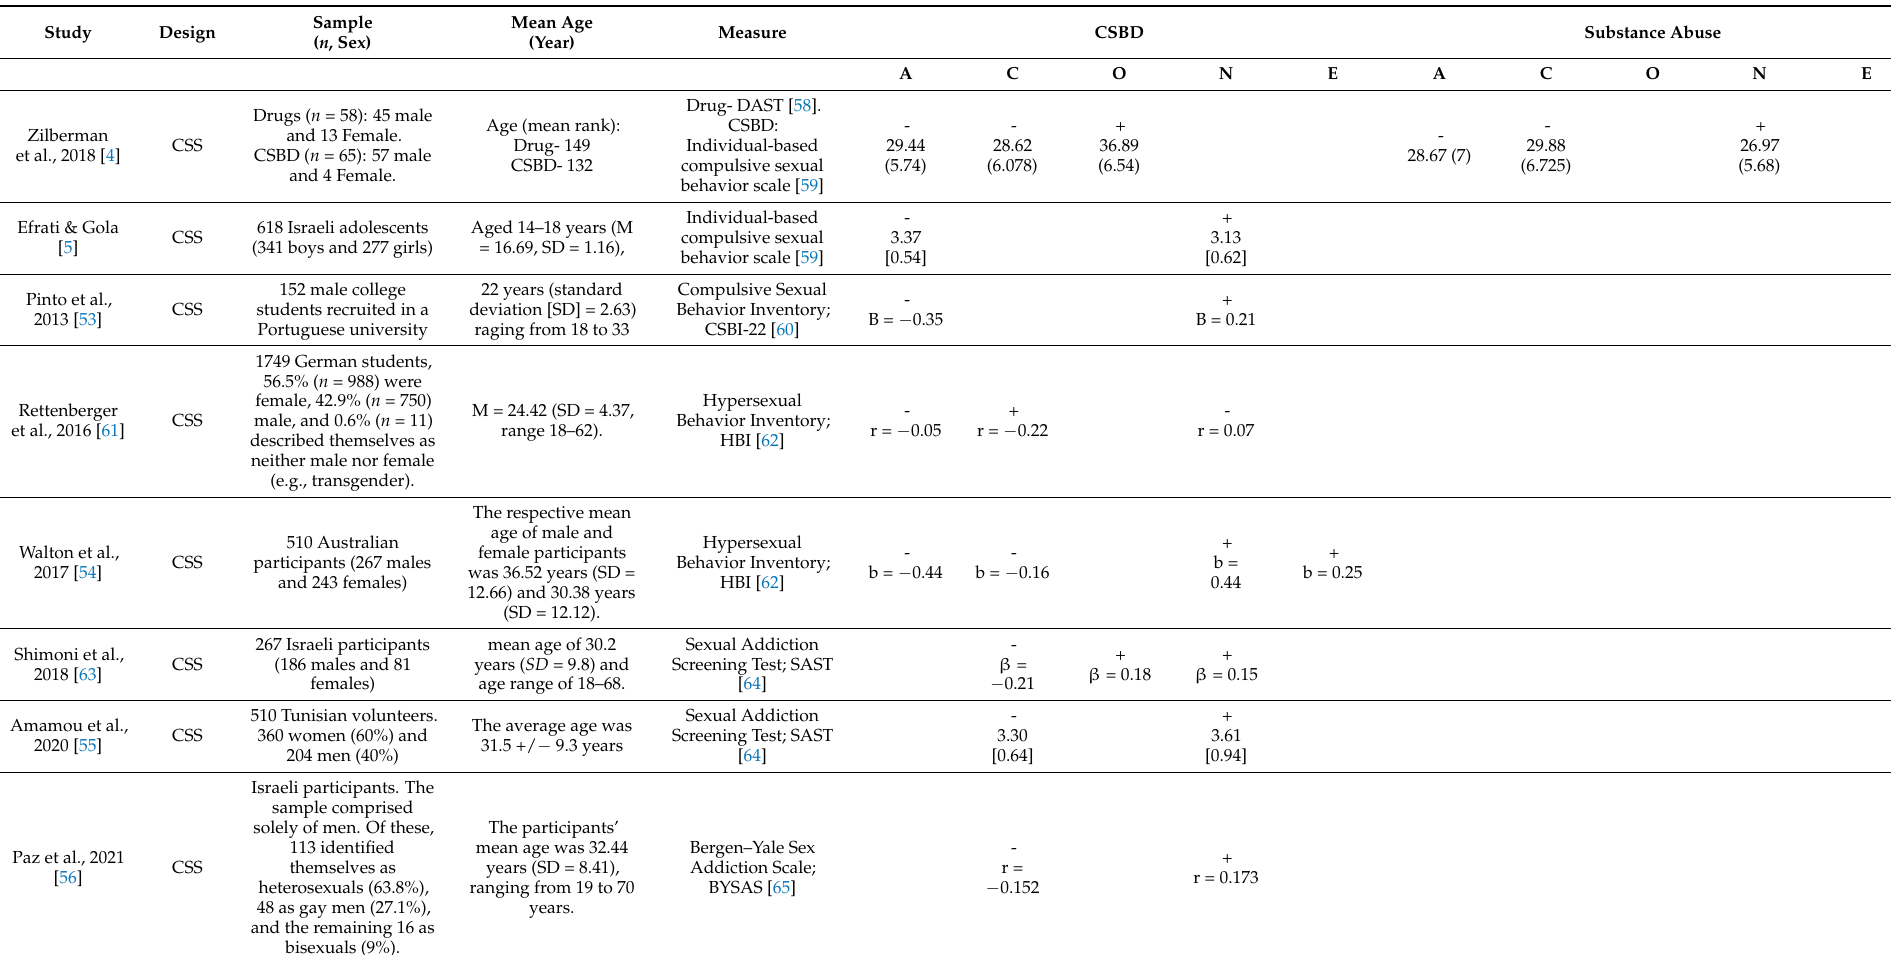
Table 1. Personality traits on CSBD and